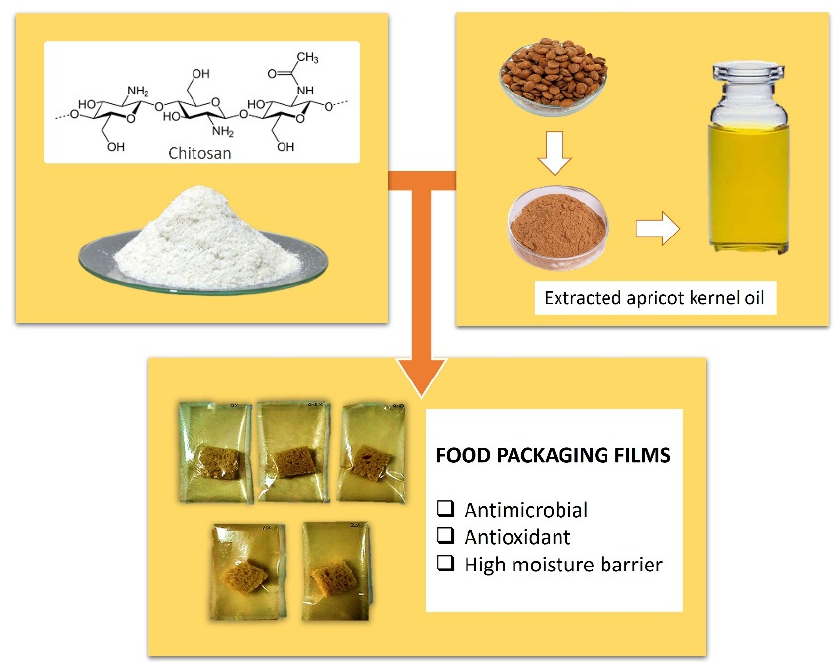
Figure 6. Chitosan films incorporated with AKEO